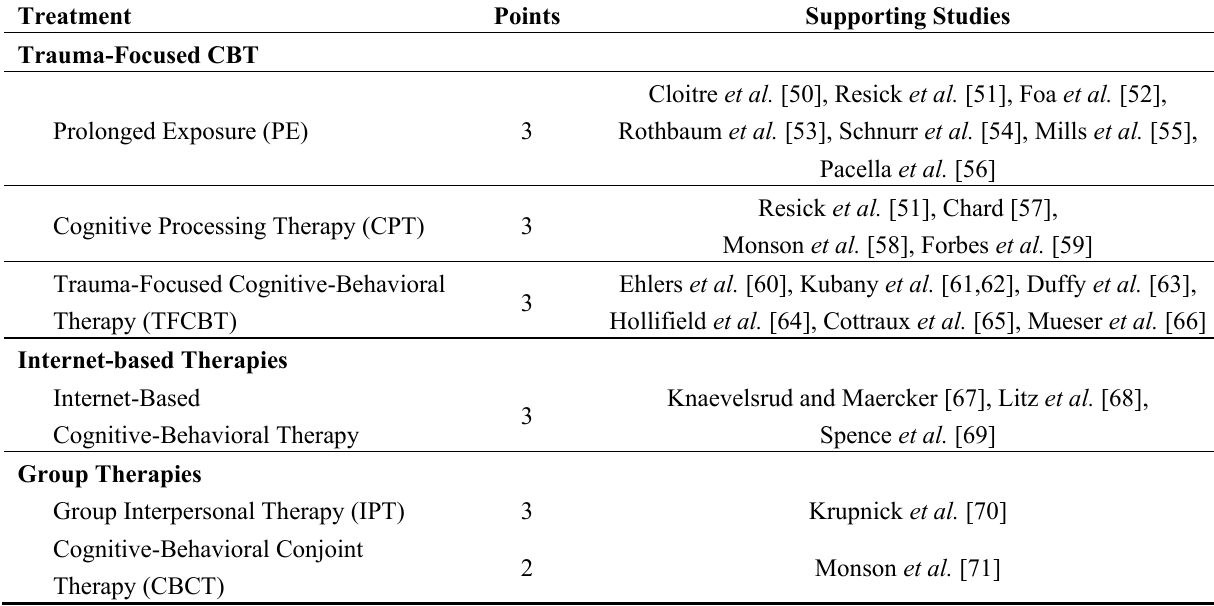
Table 3. Psychotherapy treatments scored by the